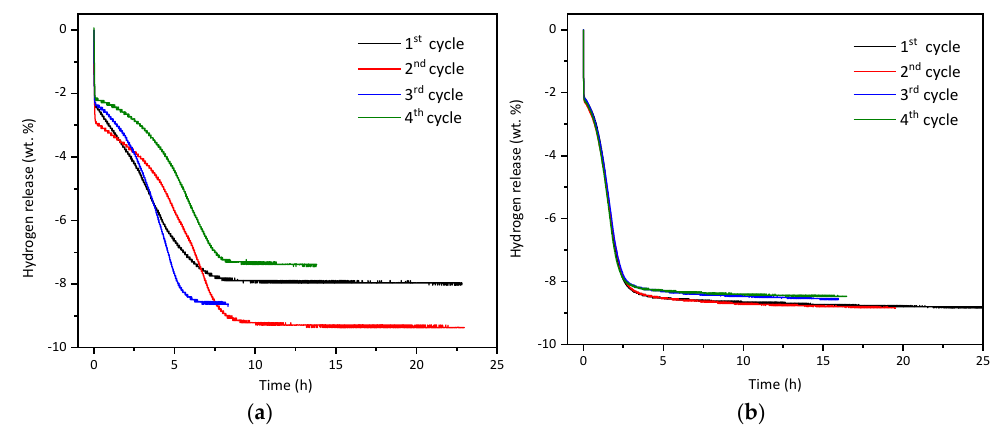
Figure 5. Dehydrogenation of the pristine Li-RHC ( a ) and Li-RHC + AlTi 3 ( b ). Compared with the pristine material Li-RHC, the addition of AlTi 3 nanoparticles 303 significantly improves the hydrogenation–dehydrogenation kinetics of the Li-RHC. How- ever, compared with the material-doped 3TiCl 3 · AlCl 3 [50], the kinetic performance of Li-RHC + AlTi 3 leads to similar capacities and slightly slower rates. In this regard, the ef- fective amount of AlTi 3 added to the Li-RHC accounts for the observed kinetic performance of the Li-RHC + AlTi 3 . In this study, the powder obtained after washing and drying contains a mixture of AlTi 3 and Al 2 O 3 that appears to be the predominant phases (Figures 2 and 3). Therefore, the used additives are not composed of 100% of AlTi 3 . The presence of Al 2 O 3 might lead to a reduced number of additional nucleation sites (i.e., AlTi 3 ) for the formation of MgB 2 , resulting in a slower hydrogen kinetic behavior of the Li-RHC + AlTi 3 sample compared with the already reported Li-RHC + 3TiCl 3 · AlCl 3 sample [39]. In the case of these kinds of materials, the crystallographic similarity between the newly forming phase and its parental phase can be evaluated by their interfacial energy. A minimized interfacial energy prompts a proper crystallographic matching between the newly grown phase and the parental phase. Therefore, the promoted nucleation of a product, such as MgB 2 , results in faster dehydrogenation kinetic behavior. According to the edge-to-edge matching model [63], the crystallographic matching